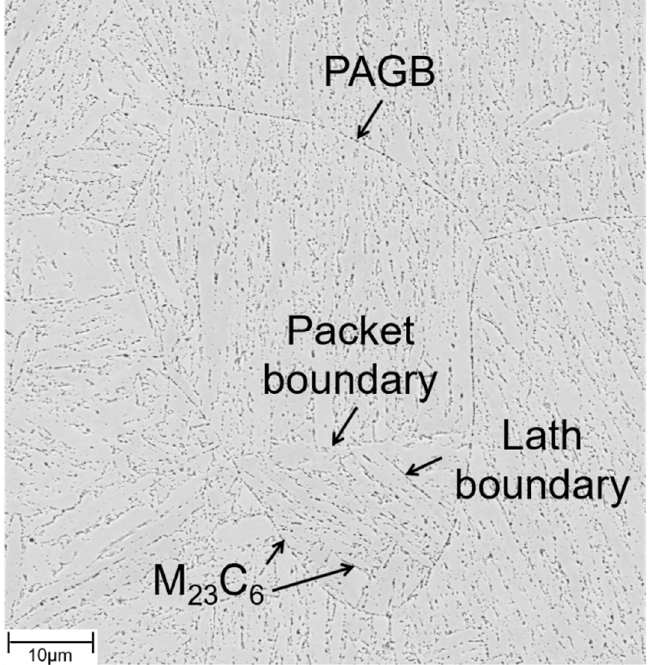
Figure 1. Characteristic microstructure of normalized and tempered grade 92 steel (SEM image). Table 1. Chemical composition of the three Crofer ® 22H sheet materials from one melt and the slab of tempered martensite grade 92 (wt.